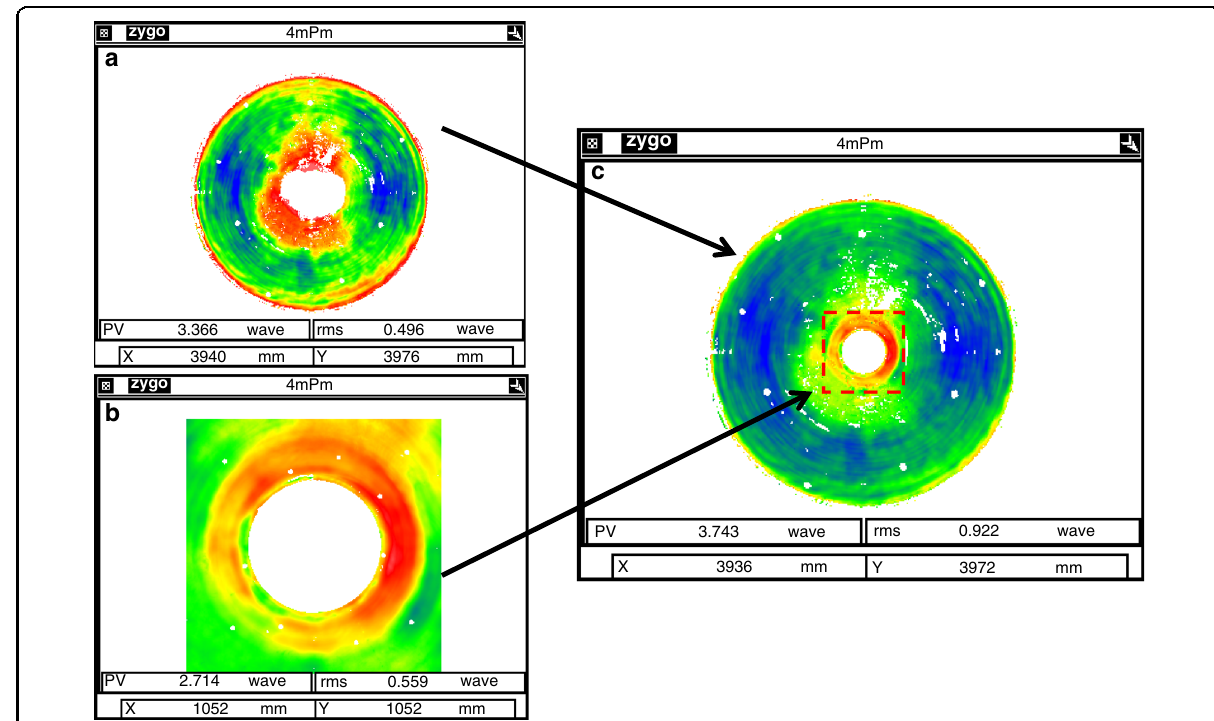
Fig. 19 Interferometric test data fusion. a CGH null test. b data from non-null test, and c fused data for the surface of the ⌀ 4.03 m mirror